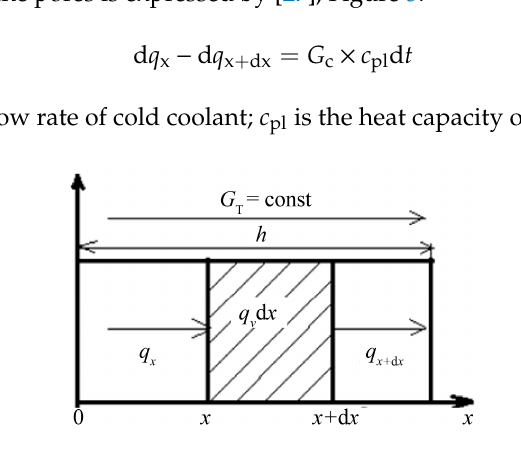
Figure 5. Porous cooling in an elementary volume.